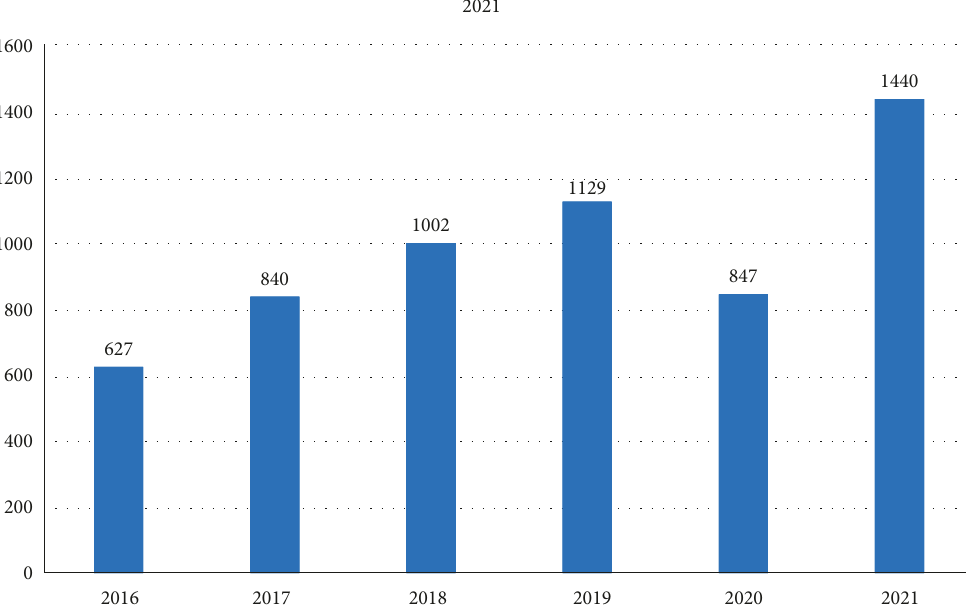
Figure 1: Number of fuel cell-related companies registered in China in 2016–2021.